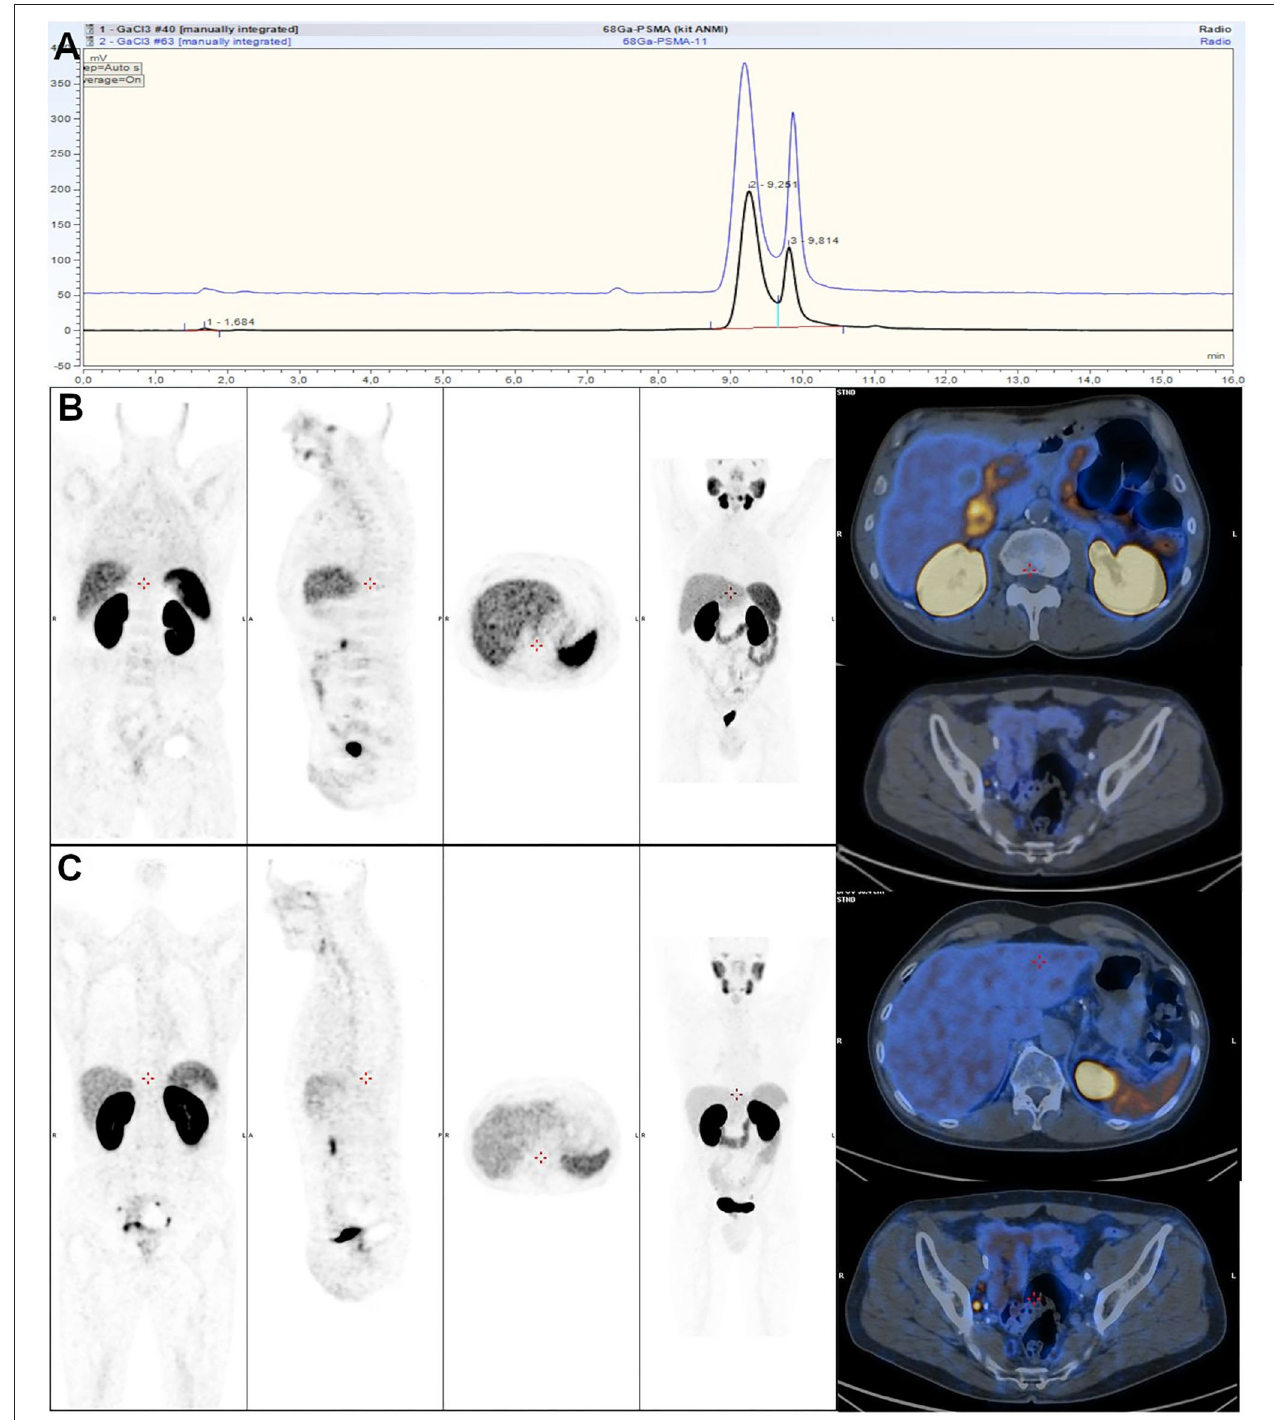
FIGURE 6 | (A) Comparison of HPLC profiles of automated (blue) and cold kit-based (black) labeling of [ 68 Ga]Ga-HBED-CC-PSMA-11. (B,C) Comparison of 2 68 Ga-PSMA-11 PET/CT acquisitions rated as good quality using 68 Ga-PSMA-11 synthetized with sterile cold kit (B) and 68 Ga-PSMA-11 synthetized with automated module (C) . (B,C) from